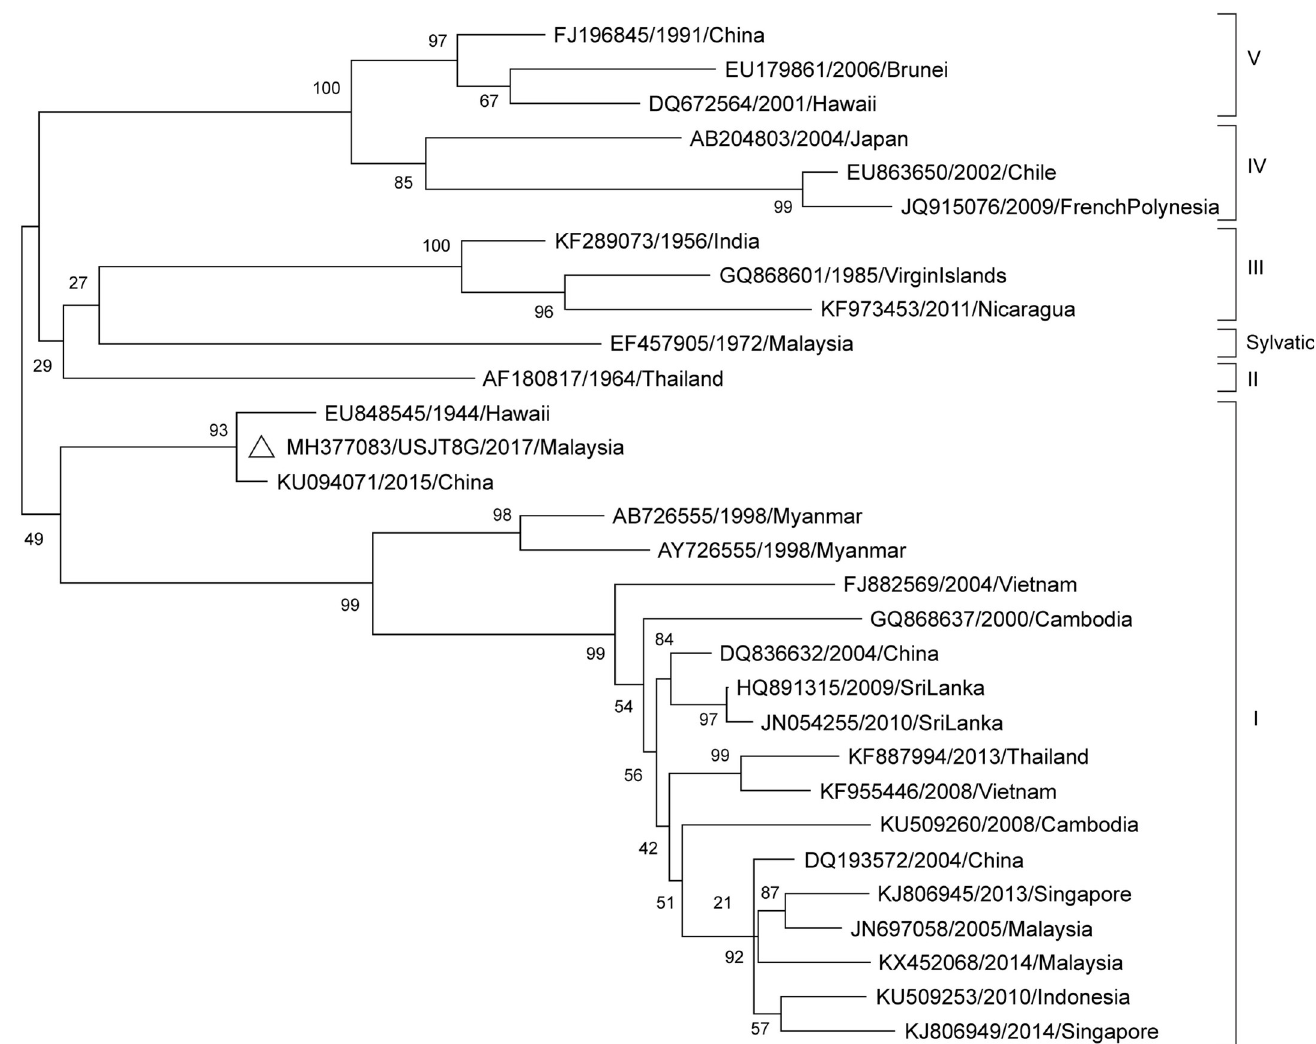
Fig 2. Phylogenetic analysis of the CprM gene sequences of DENV-1 isolates from the Klang Valley. Sample sequence of DENV-1 (429 nt) from adult Ae . aegypti collected from Selangor in this study (marked with a white triangle) is labelled with the GenBank accession number, sample ID and year of collection. Bootstrap values (1,000 replicates) are shown next to the branches. Taxa of reference sequences are labelled as the GenBank accession numbers, year and country of sample